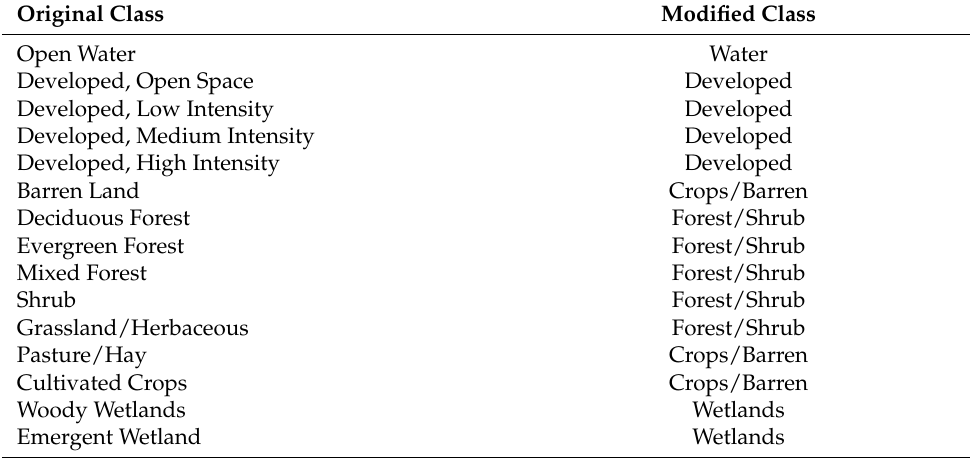
Table A2. Land cover reclassification.